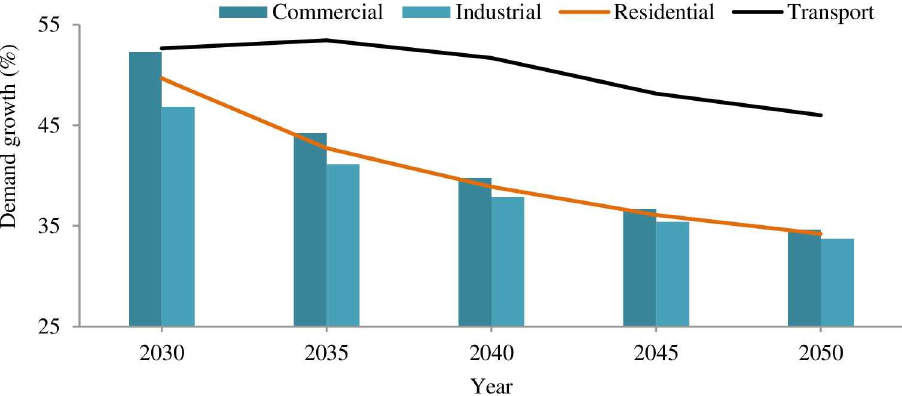
Fig 12. Energy demand growth rate. Within a five year interval (2025–2050), the energy growth rate for these sectors is 33–53%. The growth rate for residential, commercial, industrial and street-lighting were 34–50%, 34–42%, 33–46% and 46–53%